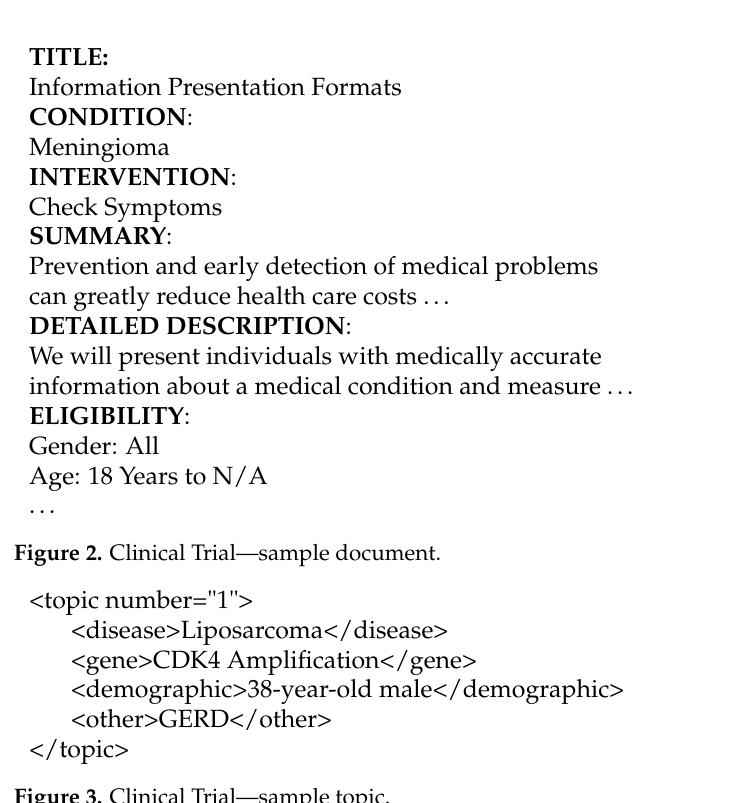
Figure 3. Clinical Trial—sample topic.